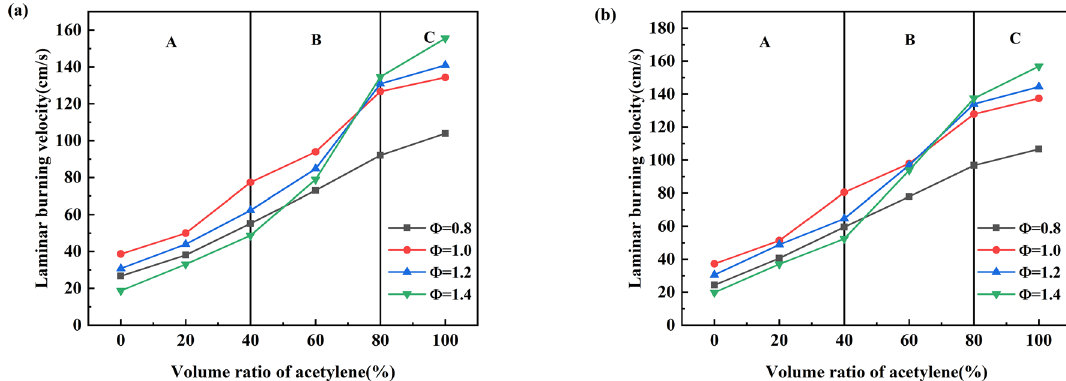
Figure 7. S L value of mixed gas [( a ) S L from spherical flame method, ( b ) S L from GRI Mech